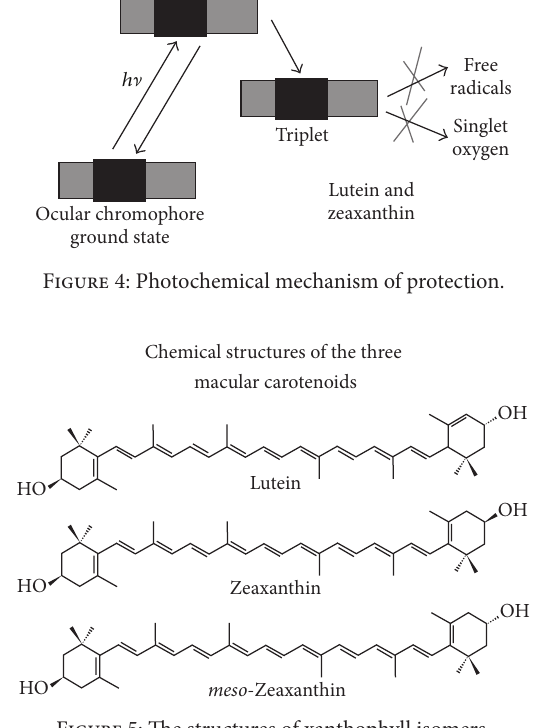
Figure 5: The structures of xanthophyll